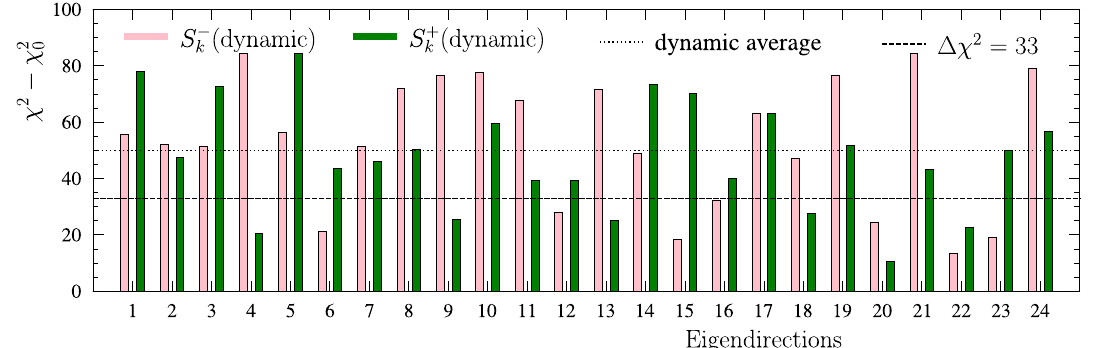
Fig. 5 The χ 2 as a function of eigenvector directions z i (black curves) compared to the ideal quadratic form χ 2 global